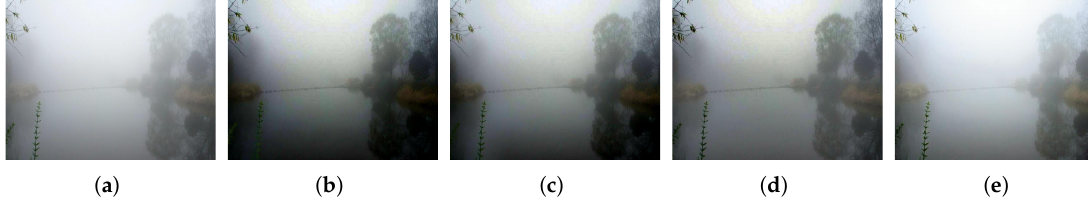
Figure 15. Example of failure cases. ( a ) Input image. ( b ) CAP. ( c ) DehazeNet. ( d ) MSCNN. ( e )